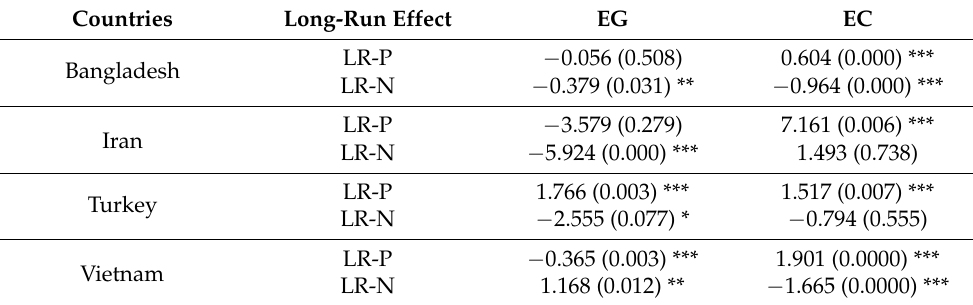
Table 9. Results of long-run asymmetric